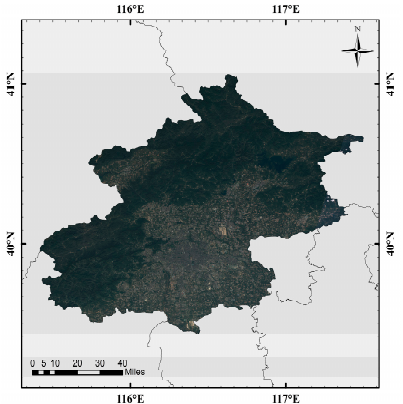
Figure 1. Geolocation of Beijing shown by GF-1 WFV